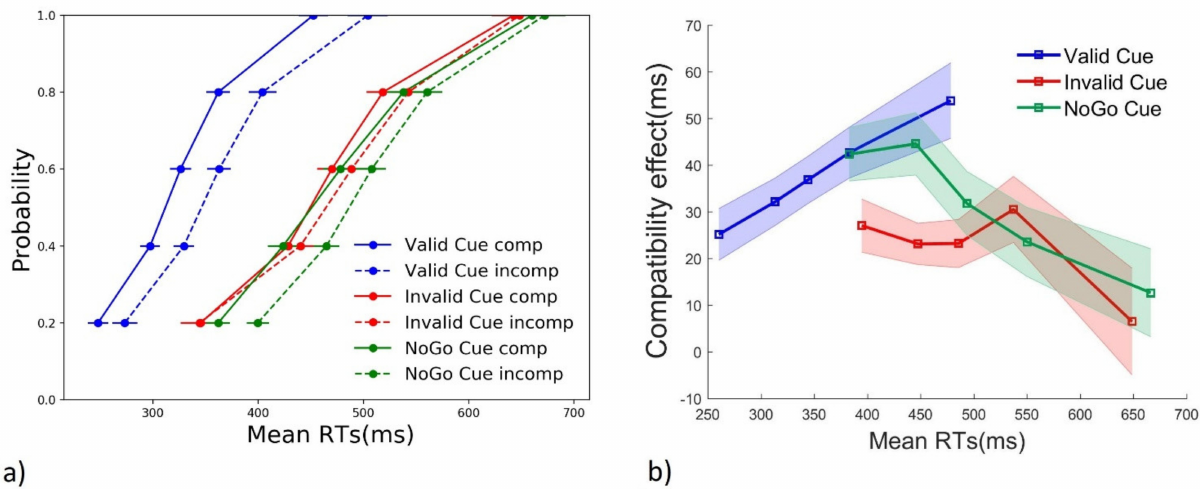
Figure 3. Cumulative distribution function of correct binned RTs ( a ). Delta plots calculated over correct trials ( b ). The compatibility effect (incompatible–compatible) is plotted as a function of RTs separately for each cue condition. Horizontal error bars ( a ) and shaded areas ( b ) represent the standard